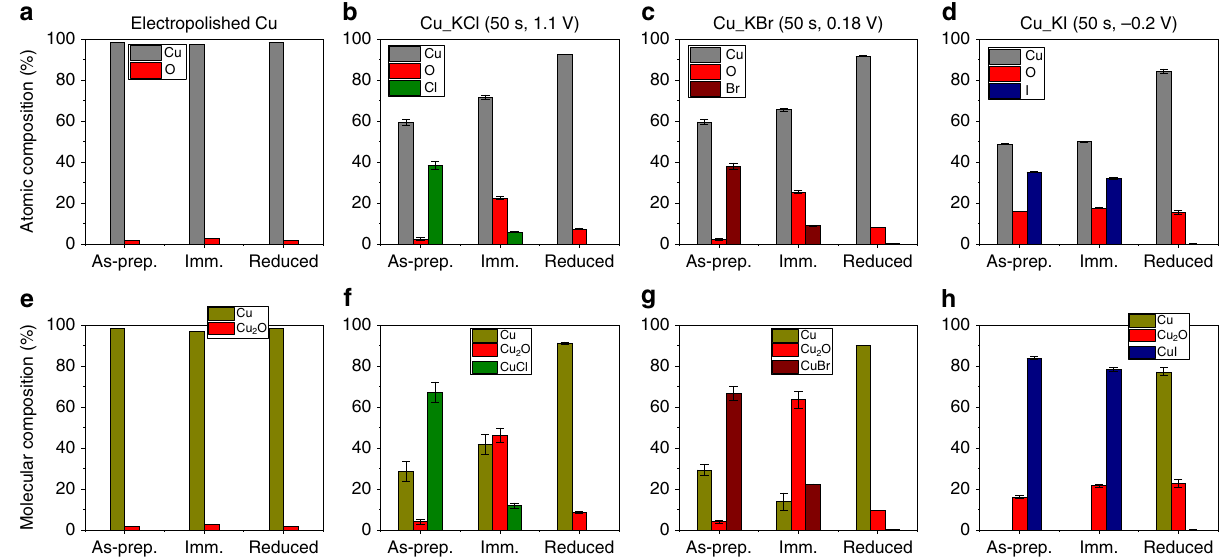
Fig. 4 Energy-dispersive X-ray spectroscopy. a – d Raw data of atomic composition of electropolished Cu foil and halogenated Cu foils as measured by EDS. e – h Compositions of molecular species from converted EDS data. ‘ As-prep. ’ indicates the as-prepared catalyst by electropolishing or anodic halogenation. ‘ Imm. ’ indicates the catalyst underwent oxide formation by immersion in air-saturated 0.1 M KHCO 3 electrolyte for 10 min. ‘ Reduced ’ indicates the catalyst was reduced in CO 2 -saturated 0.1 M KHCO 3 electrolyte by LSV from its corresponding OCP to − 1.8 V vs Ag/AgCl at a scan rate of 5 mV/s. Source data are provided as a Source data fi